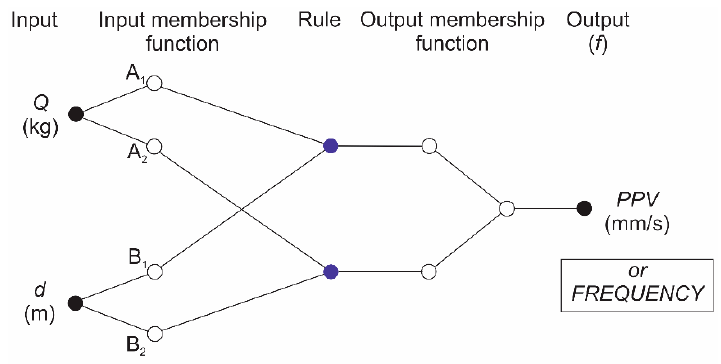
Figure 6. The fuzzy inference system included in the structure of adaptive network of the ANFIS-BLAST.